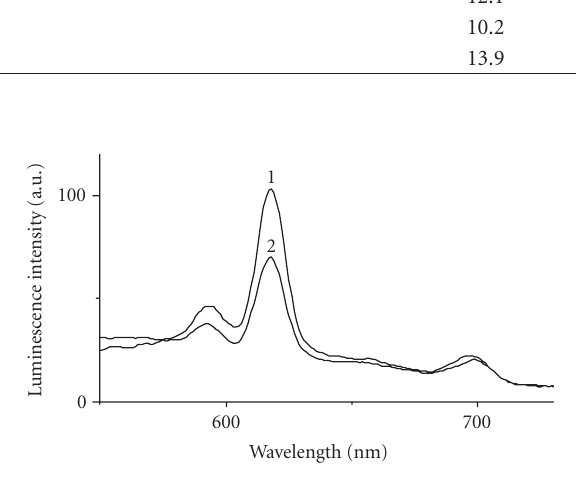
Table 4: Values of the calculated equilibrium constants and the concentration of the complexes at equilibrium conditions at 25 ◦ C. Compound